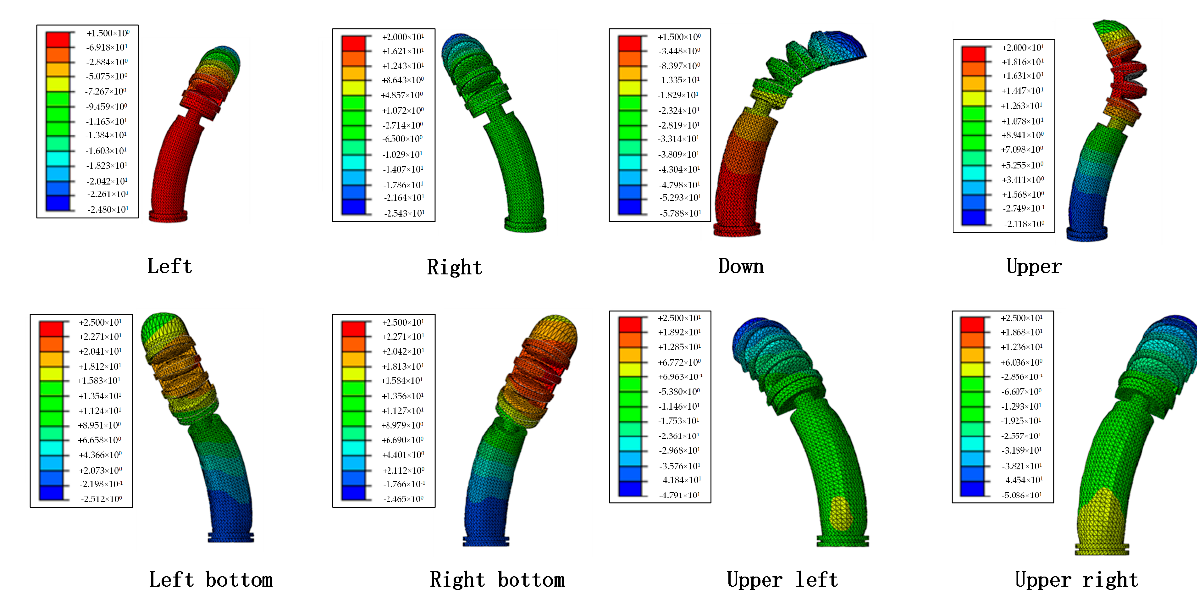
Figure 9. Thumb base joint simulation.